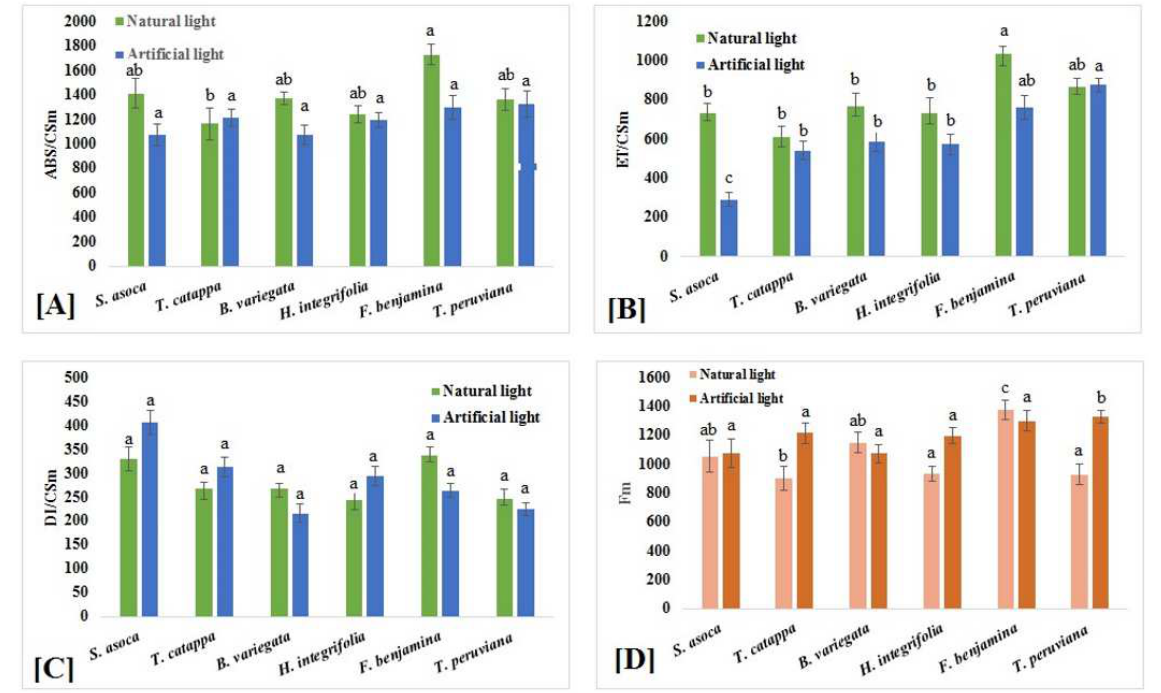
Figure 3. ( A ) Absorption per cross section (ABS/CS M ), ( B ) electron transport per cross section (ABS/CS M ), ( C ) dissipation per cross section (ABS/CS M ) and ( D ) maximum fluorescence of S. asoca , T. catappa , B. variegata , H. integrifolia , F. benjamina and T. peruviana leaves exposed to artificial-light and natural-light conditions. Values presented are the average of three replicates, and standard errors are represented by error bars. Different characters indicate significant differences among the results ( p ≤ 0.05).